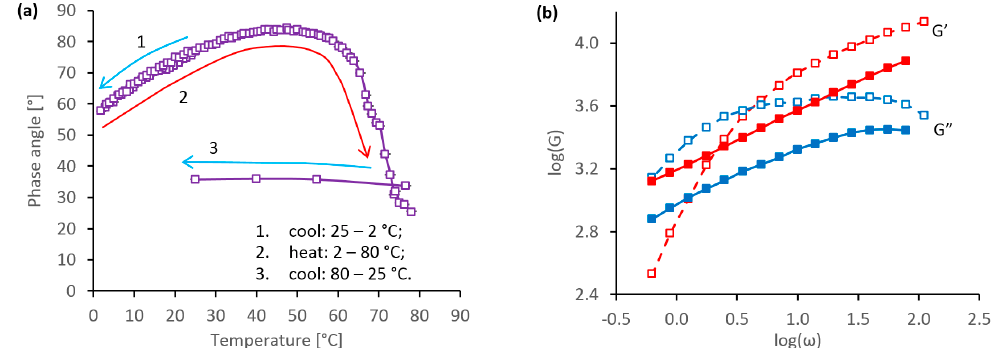
Figure 6. Rheological behaviour during thermal gelation of a silk feedstock specimen at elevated temperature: ( a ) changes in phase angle at 0.1 Hz, during cooling from 25 to 2 °C, subsequent heating from 2 to 80 °C and, finally, cooling from 80 to 25 °C; ( b ) comparison between oscillatory data at 25 °C, prior to (open symbols and dashed lines) and after (filled symbols and solid lines) the temperature cycle shown in ( a ). The arrows in ( a ) indicate the direction of temperature change.